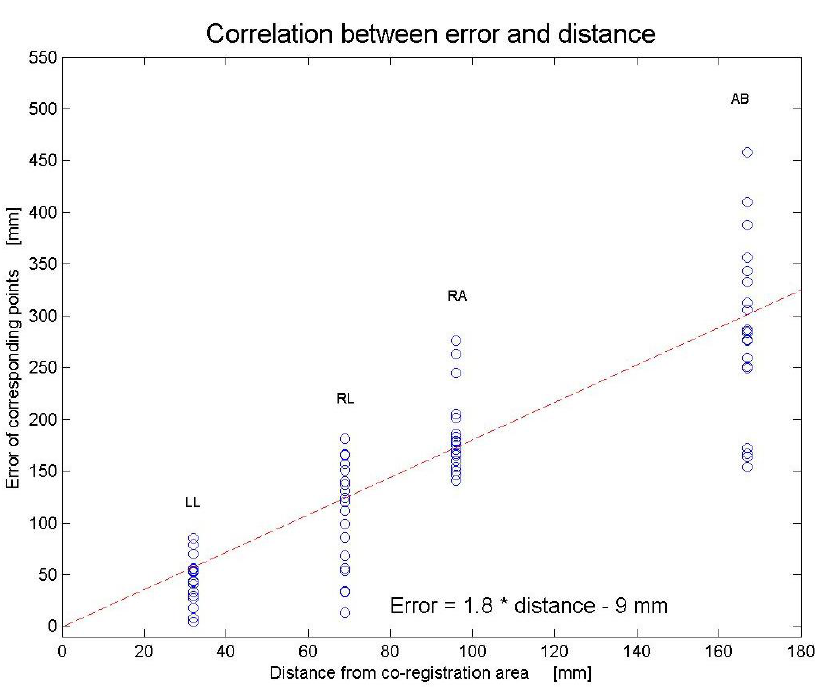
Figure 4. Correlation between error of corresponding points and distance to co-registration area. Line of best fit (dashed line) is